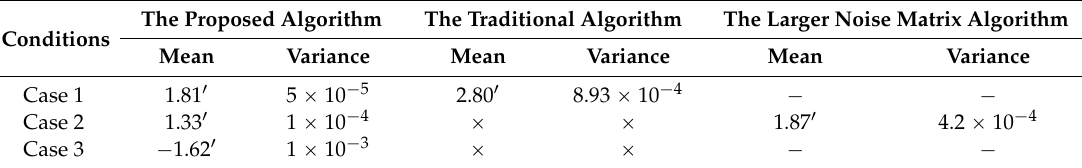
Table 4. Statistics of heading errors based on the closed-loop KF.